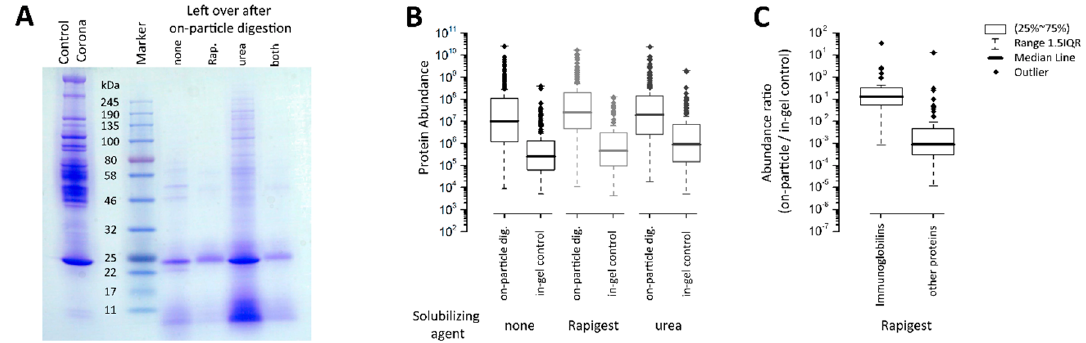
Figure 6. Analysis of the left-over proteins after on-particle digestion of corona on SiO 2 NMs. ( A ) SDS-PAGE of analytes bound onto the SiO 2 NMs after on-particle digestion. ( B ) Box plot illustrating protein abundances determined for each individual protein in the original on-particle digestion and in the in-gel control. ( C ) Calculated protein abundance ratios (on-particle/in-gel control) revealed significantly higher ratios for immunoglobulins remaining attached to the NMs compared to other proteins.